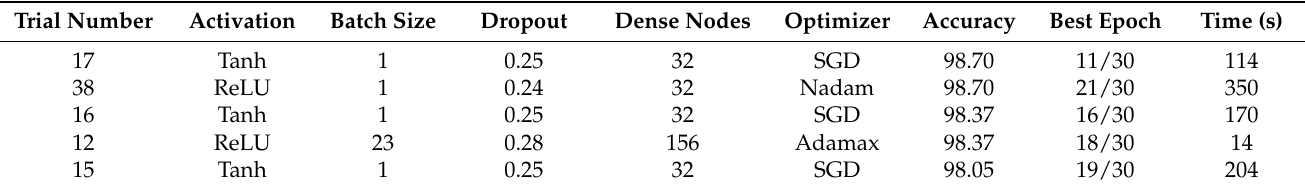
Table 4. The top five most accurate models.